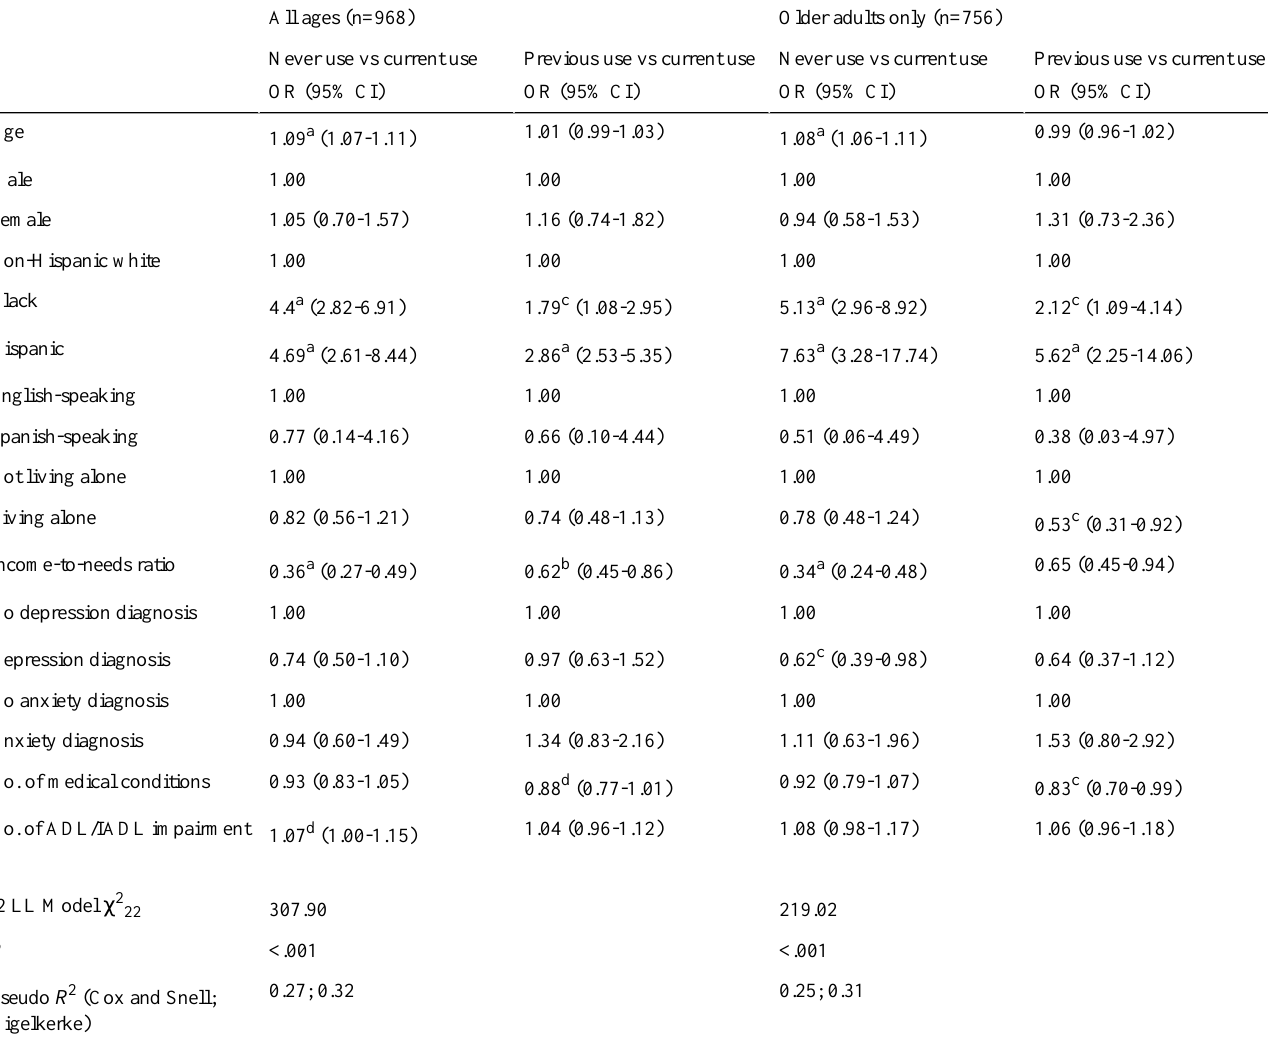
Table 3. Correlates of Internet use and nonuse: odds ratios (OR) from multinomial regression